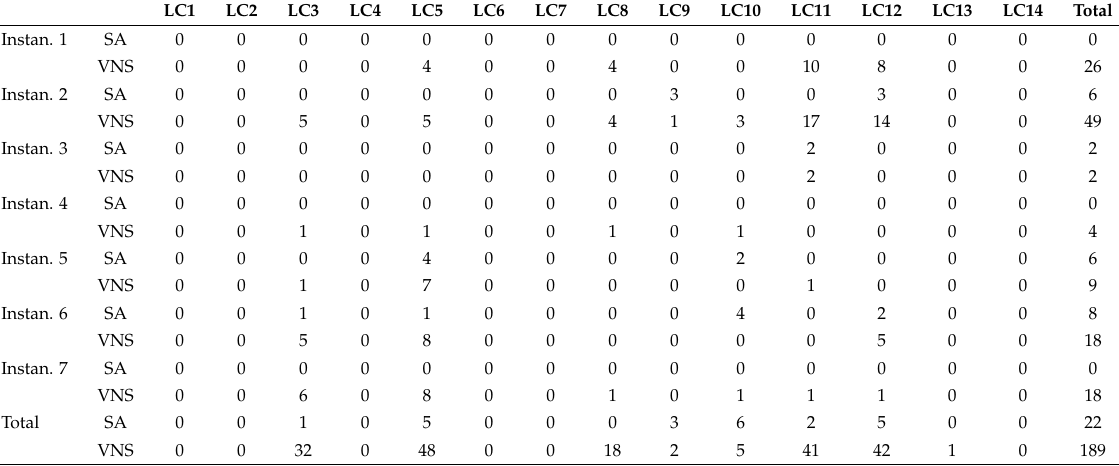
Table 5. Constraint violation